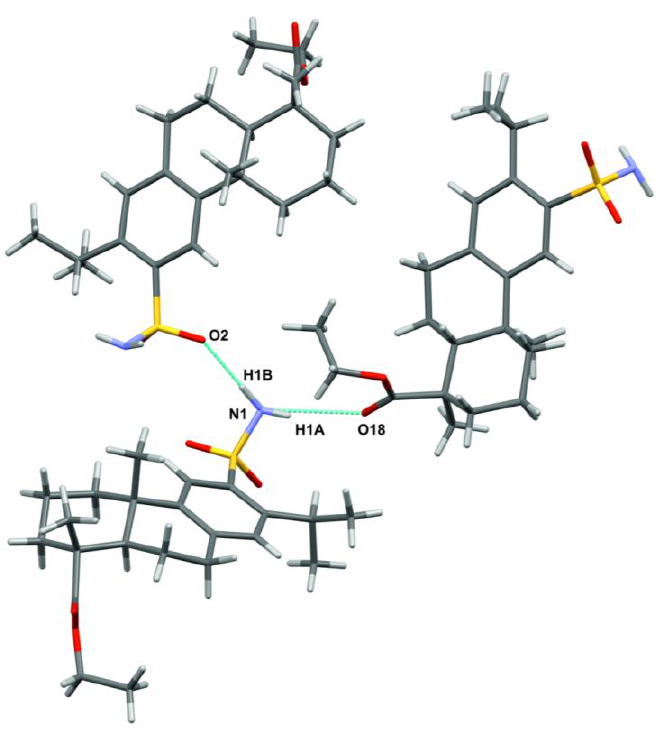
Figure 3. The system of hydrogen bonds in a crystal of 3 .